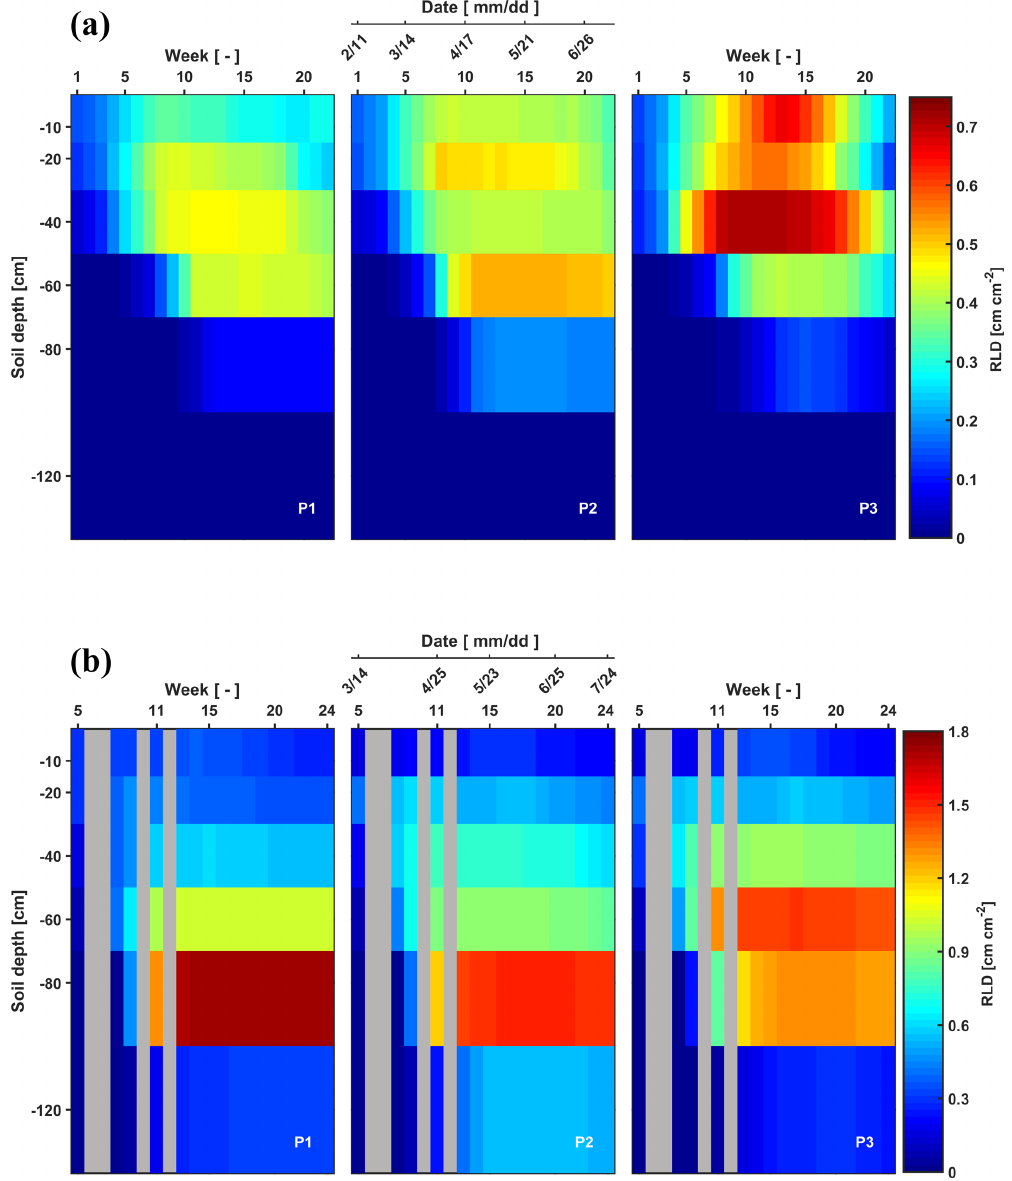
Figure 3. Depth–time distribution of root length density (RLD) in the three plots (P1: sheltered; P2: rainfed; P3: irrigated) of (a) the stony (F1) soils and (b) silty (F2) soils from 11 February to 11 July 2014 and from 14 March to 24 July 2014, respectively. There are no measurements in the gray